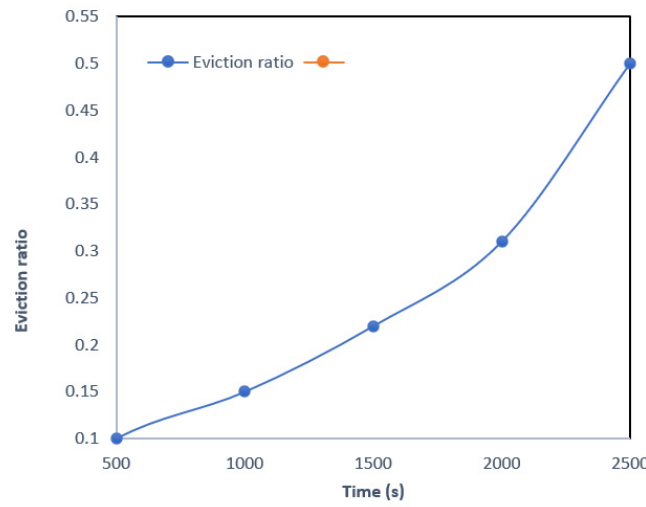
Figure 3. Eviction ratio at different simulation run times.